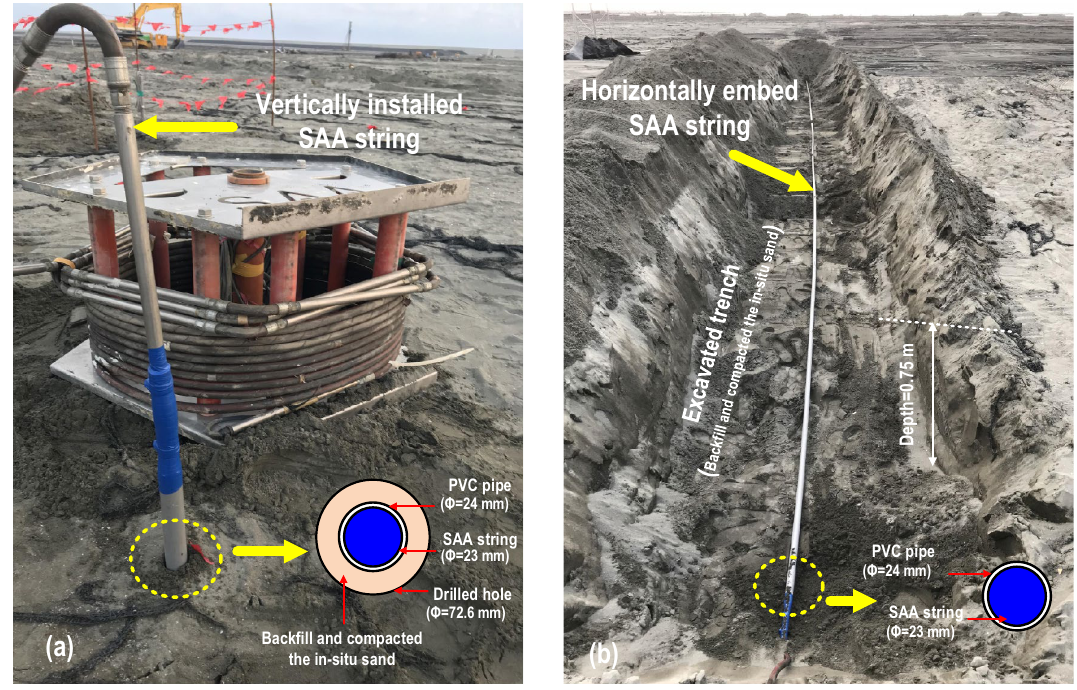
Figure 2. Photos of SAA string measurement on site: ( a ) vertically installed string for monitoring the acceleration caused by compaction at various depths and ( b ) horizontally embedded string for monitoring the acceleration caused by compaction at various propagation